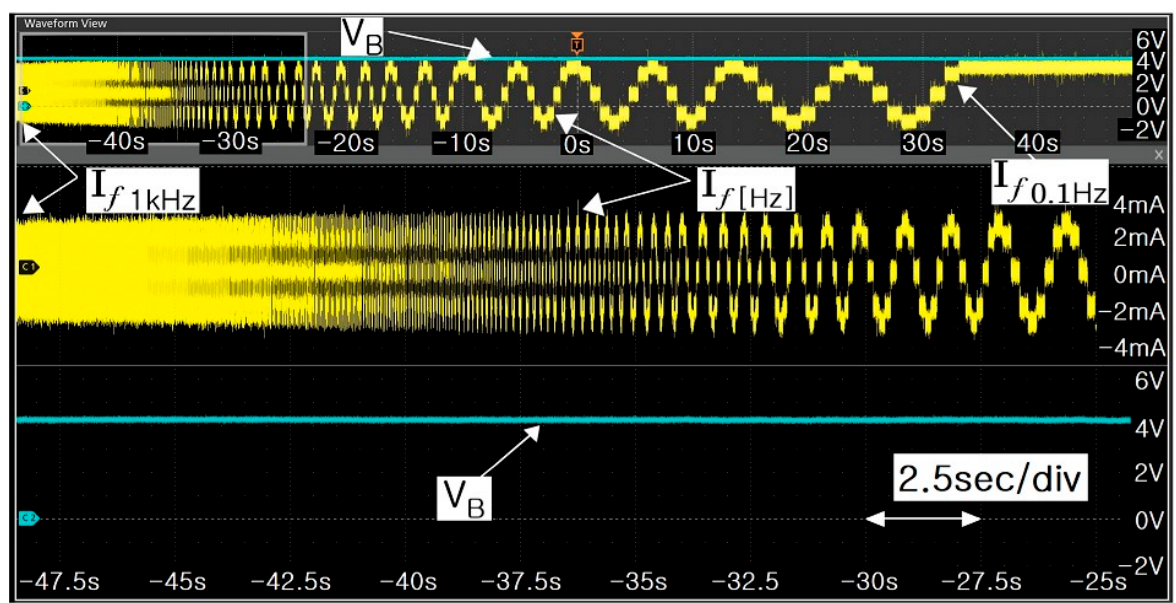
Figure 16. Voltage and current waveforms when measuring impedance spectrum.